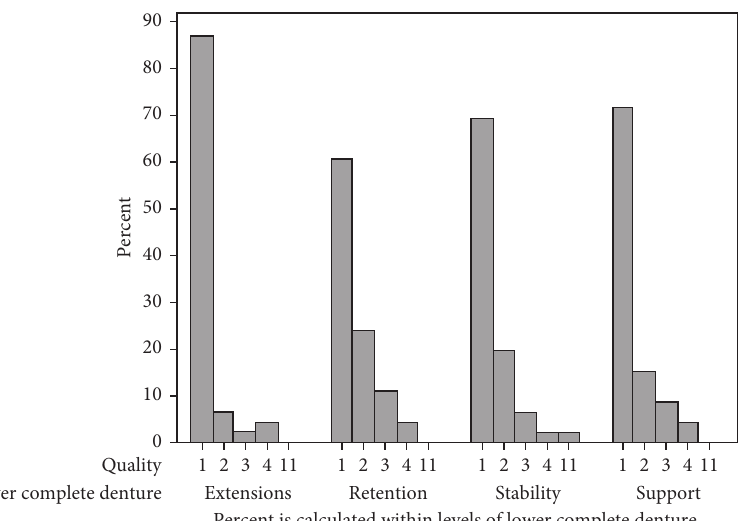
Figure 5: Level of satisfaction with the lower complete denture in relation to retention, stability, support, and extensions.